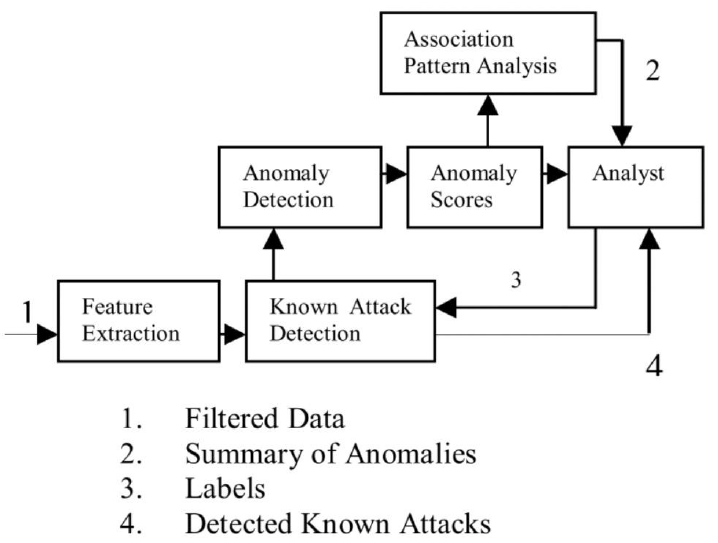
Figure 3. NIDS process flowchart: (1) filtered data to be the input data and extract the feature patterns, (2) check the association anomaly pattern analysis, (3) mark labels after analyst, and (4) detect known attack results.